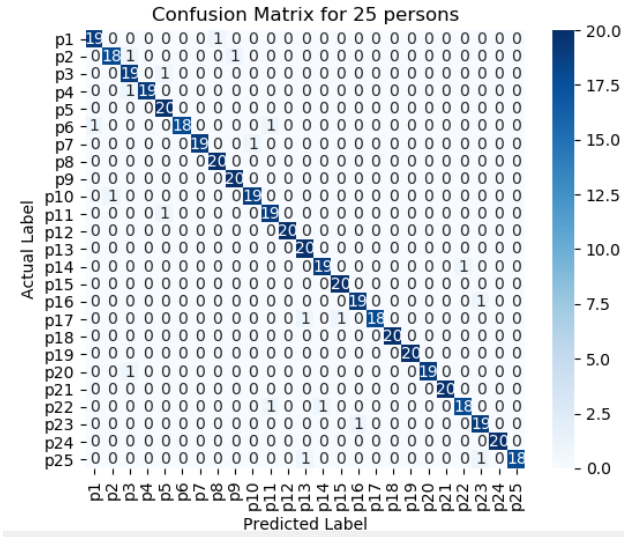
Figure 14. Confusion matrix of the proposed model for the twenty persons.